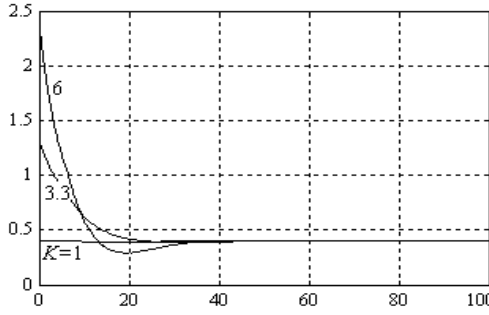
Figure 28. Responses y ( t ) to a unit step setpoint for K = 1; 3.3; 6.